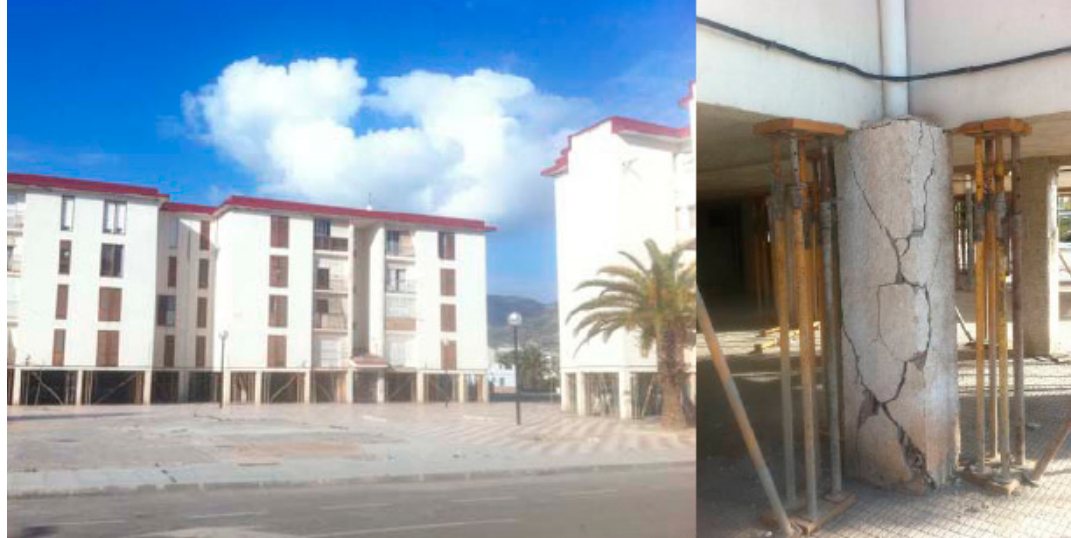
Figure 9. Overview of the San Fernando neighborhood after the 11 May 2011 earthquake [6]. Widespread damage can be observed in columns on the ground floor.